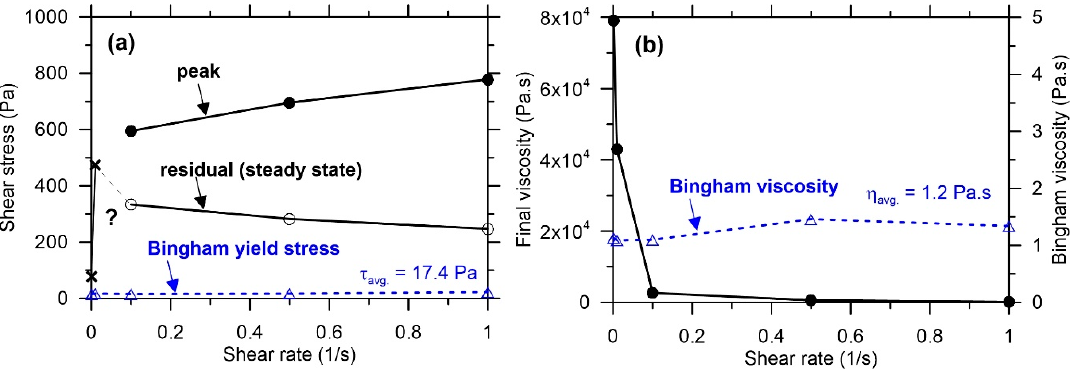
Figure 5. Static and dynamic rheological properties of sand-rich mine tailings: ( a ) Peak, residual shear stress, and the Bingham yield stresses; ( b ) final viscosity and the Bingham viscosity.